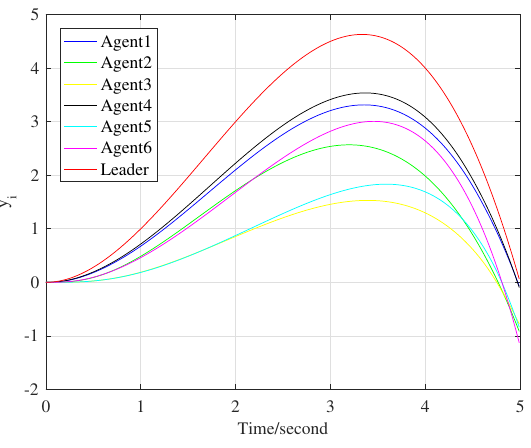
Figure 3. Tracking process at 10th iteration.